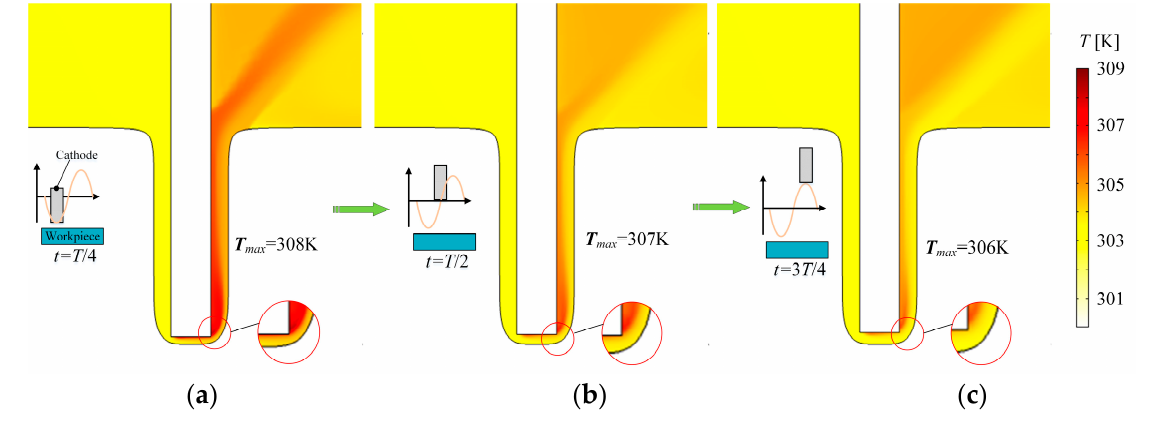
Figure 7. Distributions of electrolyte temperature over time; ( a ) t = T /4. The maximum temperature is 308 K at the cathode’s nearest position to anode; ( b ) t = T /2. The maximum temperature drops to 307 K at the middle position; ( c ) t = 3 T /4. The maximum temperature is 306 K at the farthest position. To study the temperature evolution more exactly, the line between the cathode and the anode is used as a reference line. We plotted the curves of temperature along this line in Figure 8. It is observed that the temperature near the inlet is much lower than that near the outlet. Thus, the temperature in the channel increases along the direction of electrolyte flow. The maximum temperature appears on the outlet side and its value is 307.5 K at T /4. The temperature in the whole line has an evident drop at T /2 and 3 T /4. The maximum temperature in this line drops to 305.5 K and it still appears at the outlet side at 3 T /4. This is consistent with the result shown in Figure 7.